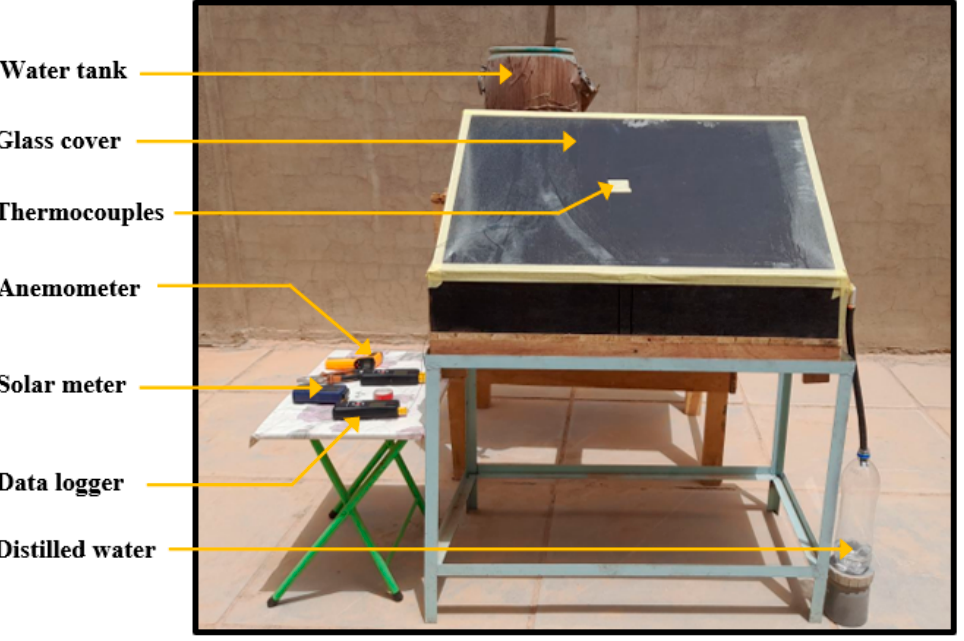
Figure 1. Photograph view of the experimental solar still.